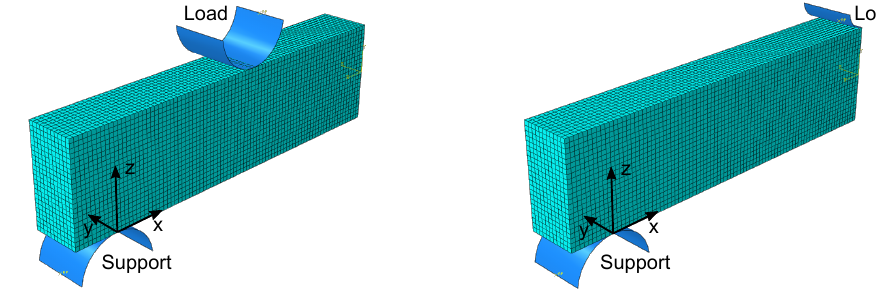
Figure 2. Quarter model of the beam for 4PB 75.5 mm and